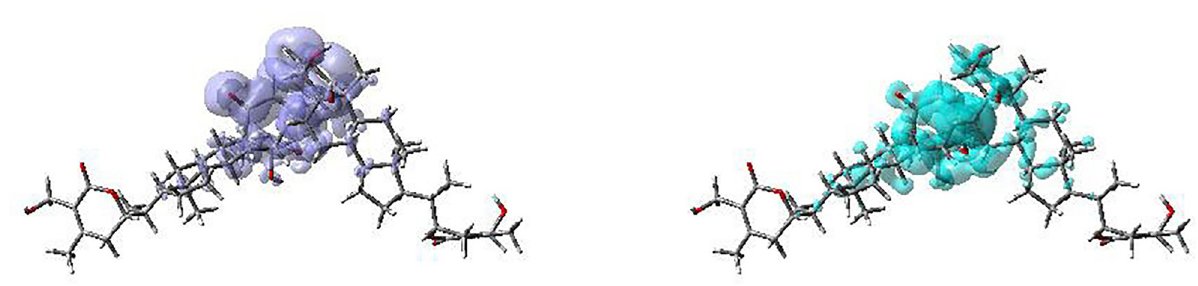
Fig 9. Graphical representation of the dual descriptor DD of Ashwangandhanolide. Top: DD > 0, Bottom: DD < 0.